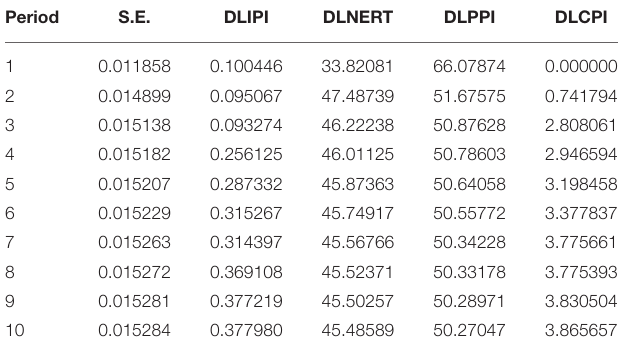
TABLE 2 | Variance decomposition of DLPPI.